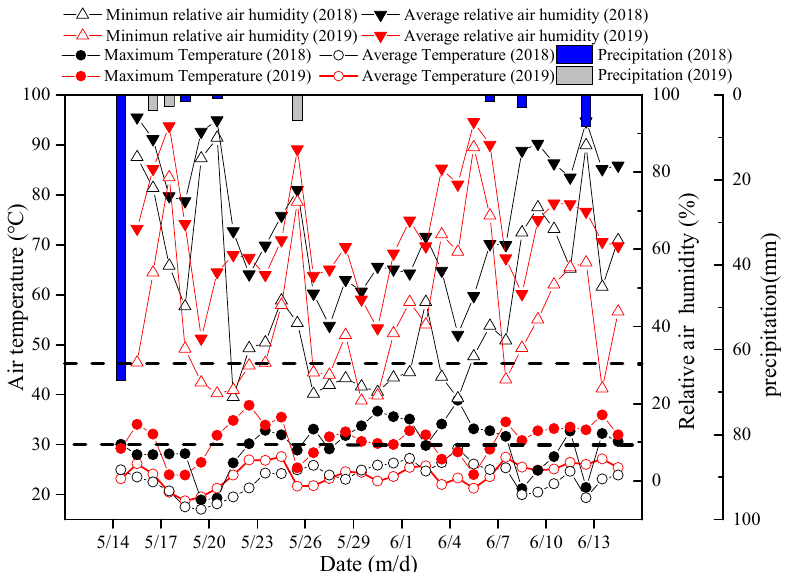
Figure 2. Air temperature, relative air humidity, and precipitation during the filling period of winter wheat in 2018 and 2019.